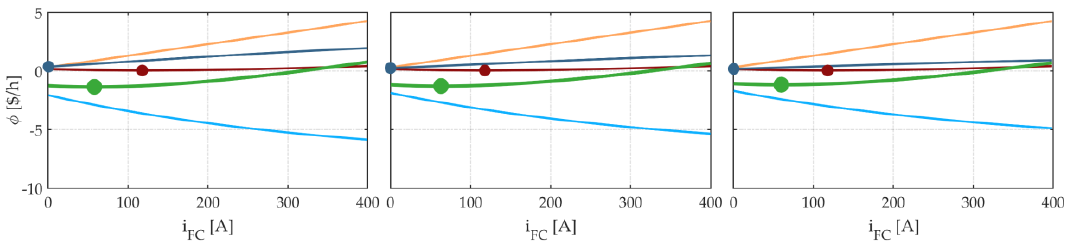
Figure 3. Evolution of the cost functions with i FC at p M = −8 kW and ε B = 0.3 ( left ), 0.5 ( middle ) and 0.7 ( right ), in which the minimum value of some curves has been highlighted by a dot: φ FC (red), φ H2 (orange), φ B (blue), φ ST (cyan), and φ (green).